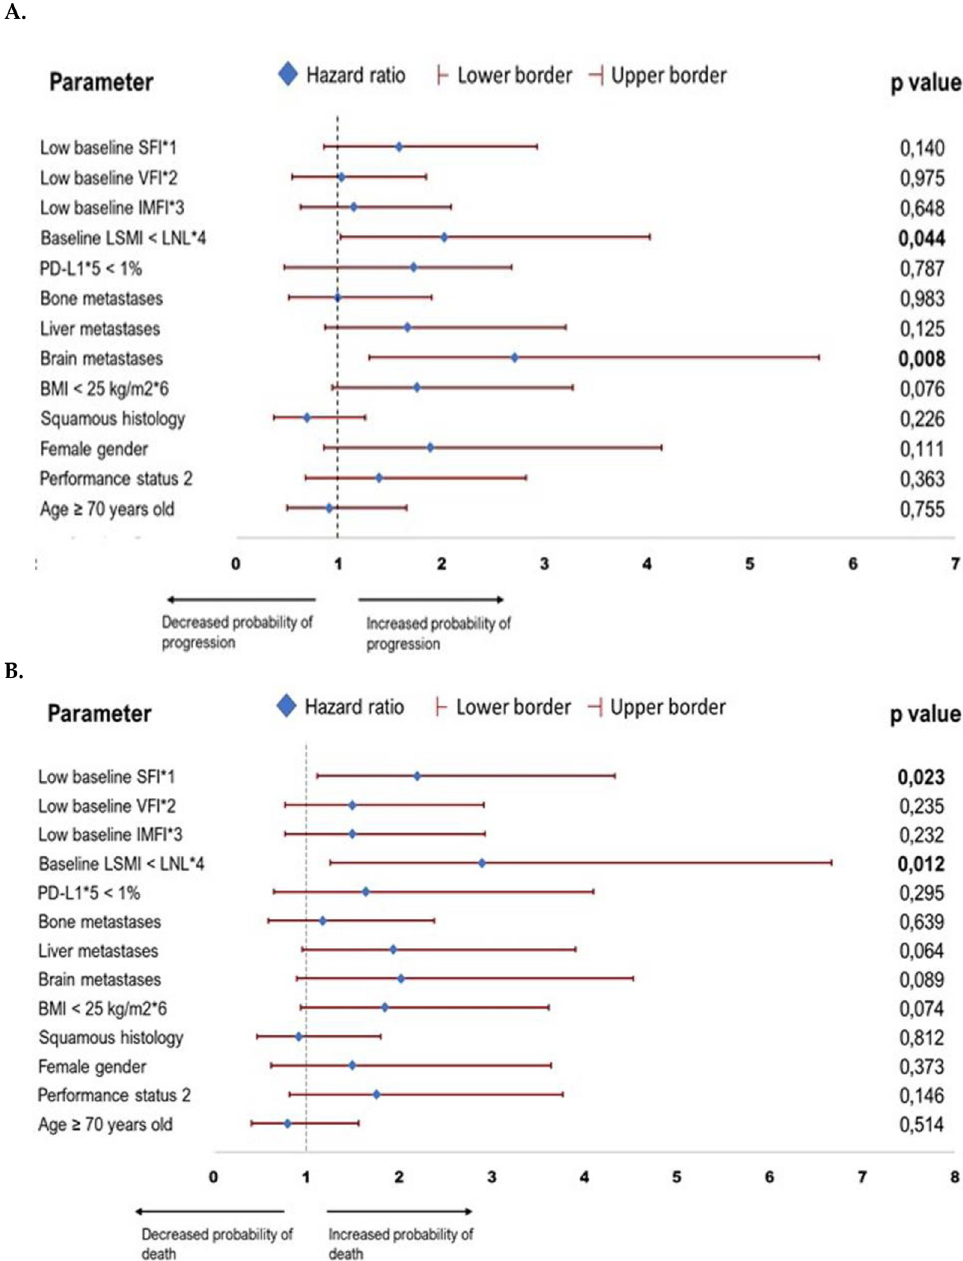
Fig 4. Forest plots demonstrating the hazard ratios and their 95% confidence intervals of the analyzed parameters on A. Probability of disease progression B. Probability of death under treatment with ICIs. Abbreviations: BMI = Body mass index; PD-L1 = Programmed death ligand-1, ICI = Immune checkpoint inhibitor; LSMI: Lumbar skeletal muscle index (At the level of 3 rd lumbar vertebra); LNL: Lower normal limit, 55 cm 2 /m 2 for males and 39 cm 2 /m 2 for females; IMFI = Intramuscular Fat Index (At the level of 3 rd lumbar vertebra); VFI = Visceral Fat Index (At the level of 3 rd lumbar vertebra); SFI = Subcutaneous Fat Index (At the level of 3 rd lumbar vertebra). � 1,2,3,4,5,6 SFI, VFI, IMFI, LSMI, PD-L1 and BMI values were calculated at the beginning of treatment with ICIs. � 1,2,3 Low for SFI, VFI and IMFI means below gender specific median value.